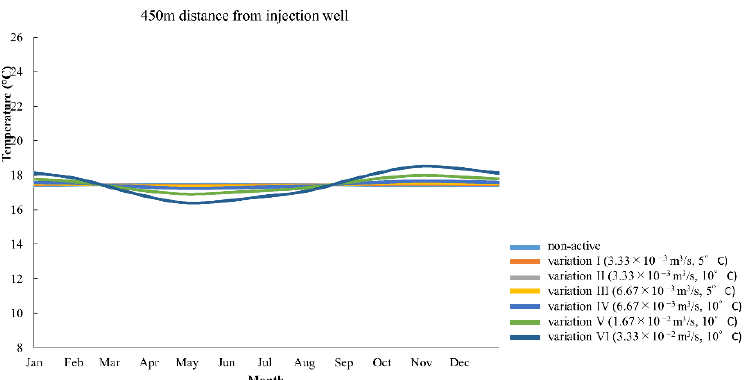
Figure 16. Thermal changes in local model 2 at 450 m distance from the injection well.